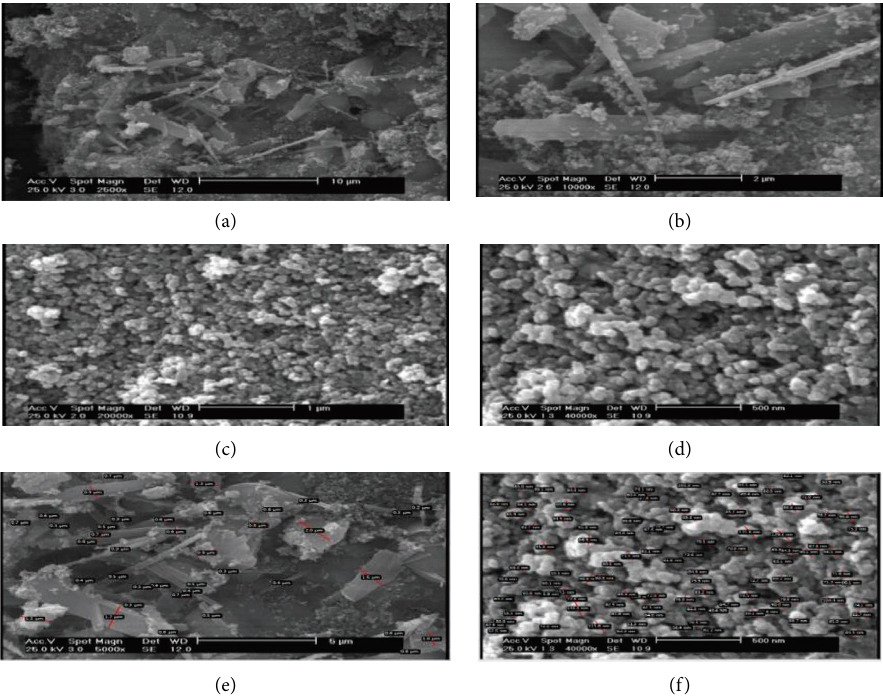
Figure 5: SEM images of low magnifcation MNCNTs (a) and high magnifcation MNCNTs (b). SEM images of low magnifcation MNCNTs/Fe 3 O 4 (c) and high magnifcation MNCNTs/Fe 3 O 4 (d). SEM images showing the size of the particles of MWCNTs (e) and MWCNTs-Fe 3 O 4 (f).